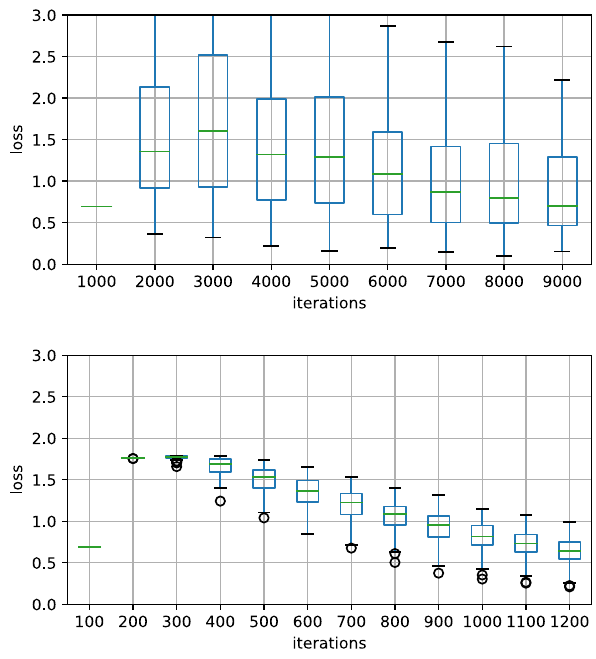
Fig. 17 The loss of low-frequency words on W2V-Vanilla model (upper subfigure) and W2V-CL model (lower subfigure). The size of boxes indicates the variance